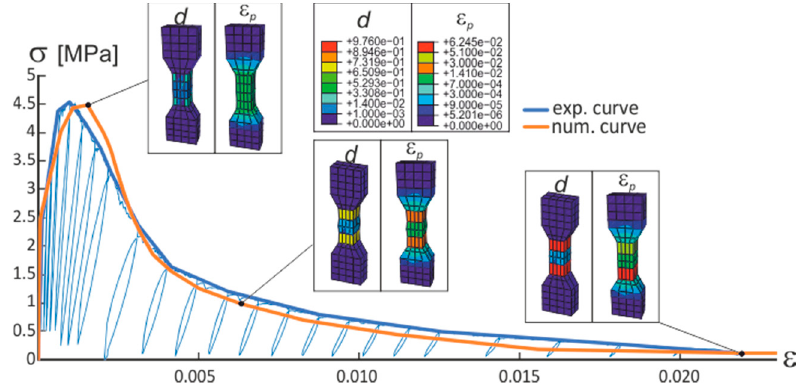
Figure 5. σ – ε numerical and experimental curves. Three snapshots of damage d and normal plastic strain ε p fields at different instants of the deformation process.